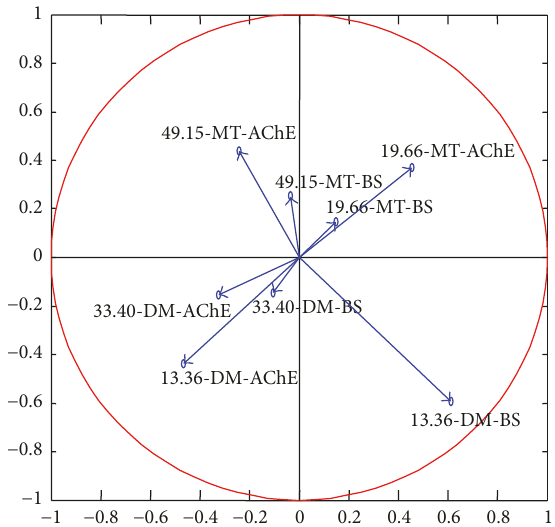
Figure 2: The correlation analysis of swimming behavior and AChE activity of D. magna based on Principal Component